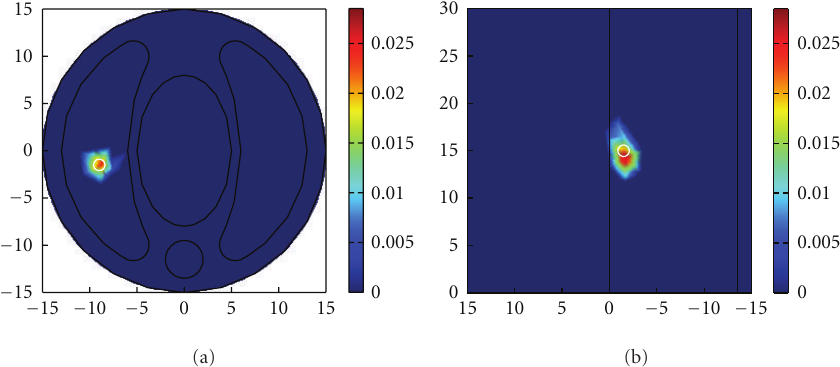
Figure 3: Reconstructed results under measurement noise level of 10% and Gaussian system error level of 1% with TTLS + IGCV: (a) x – y view of at z = 15mm plane, (b) y – z view at x = − 9mm plane; the white circle indicates the real